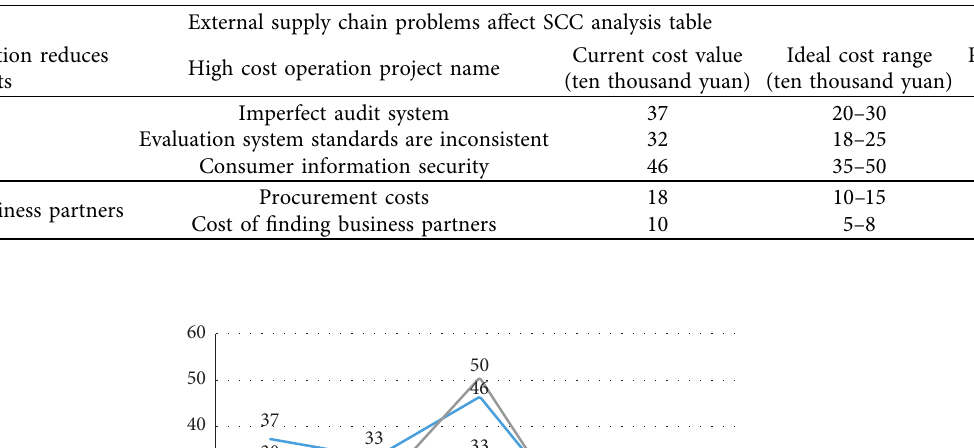
Table 1: Cost analysis table of external supply chain problems affecting supply chain.